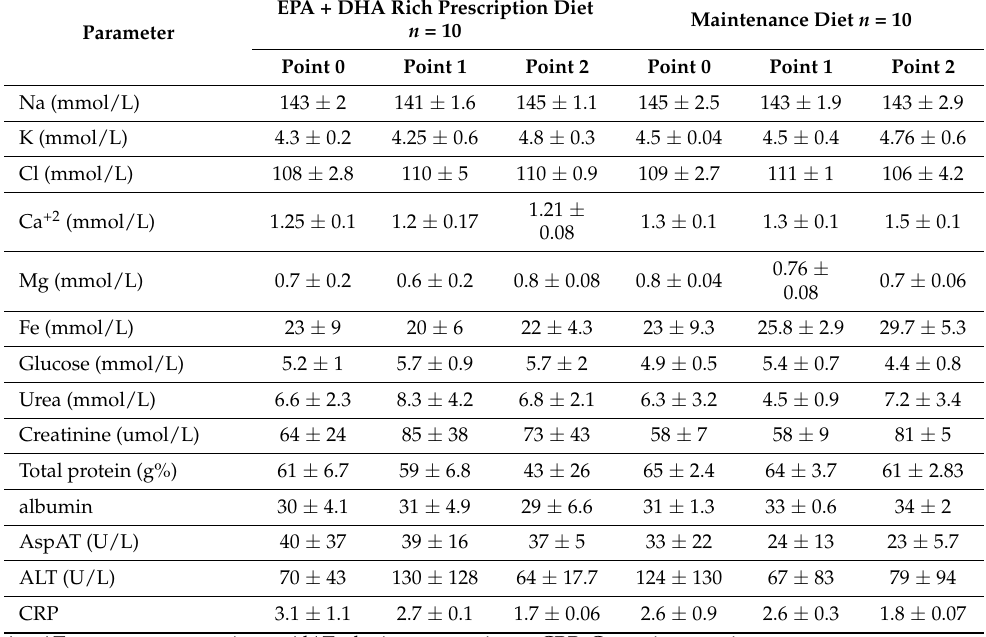
Table 4. Biochemical variables at individual time points in dogs fed the EPA + DHA rich prescription diet and maintenance diet. Data are presented as mean ± standard deviation.